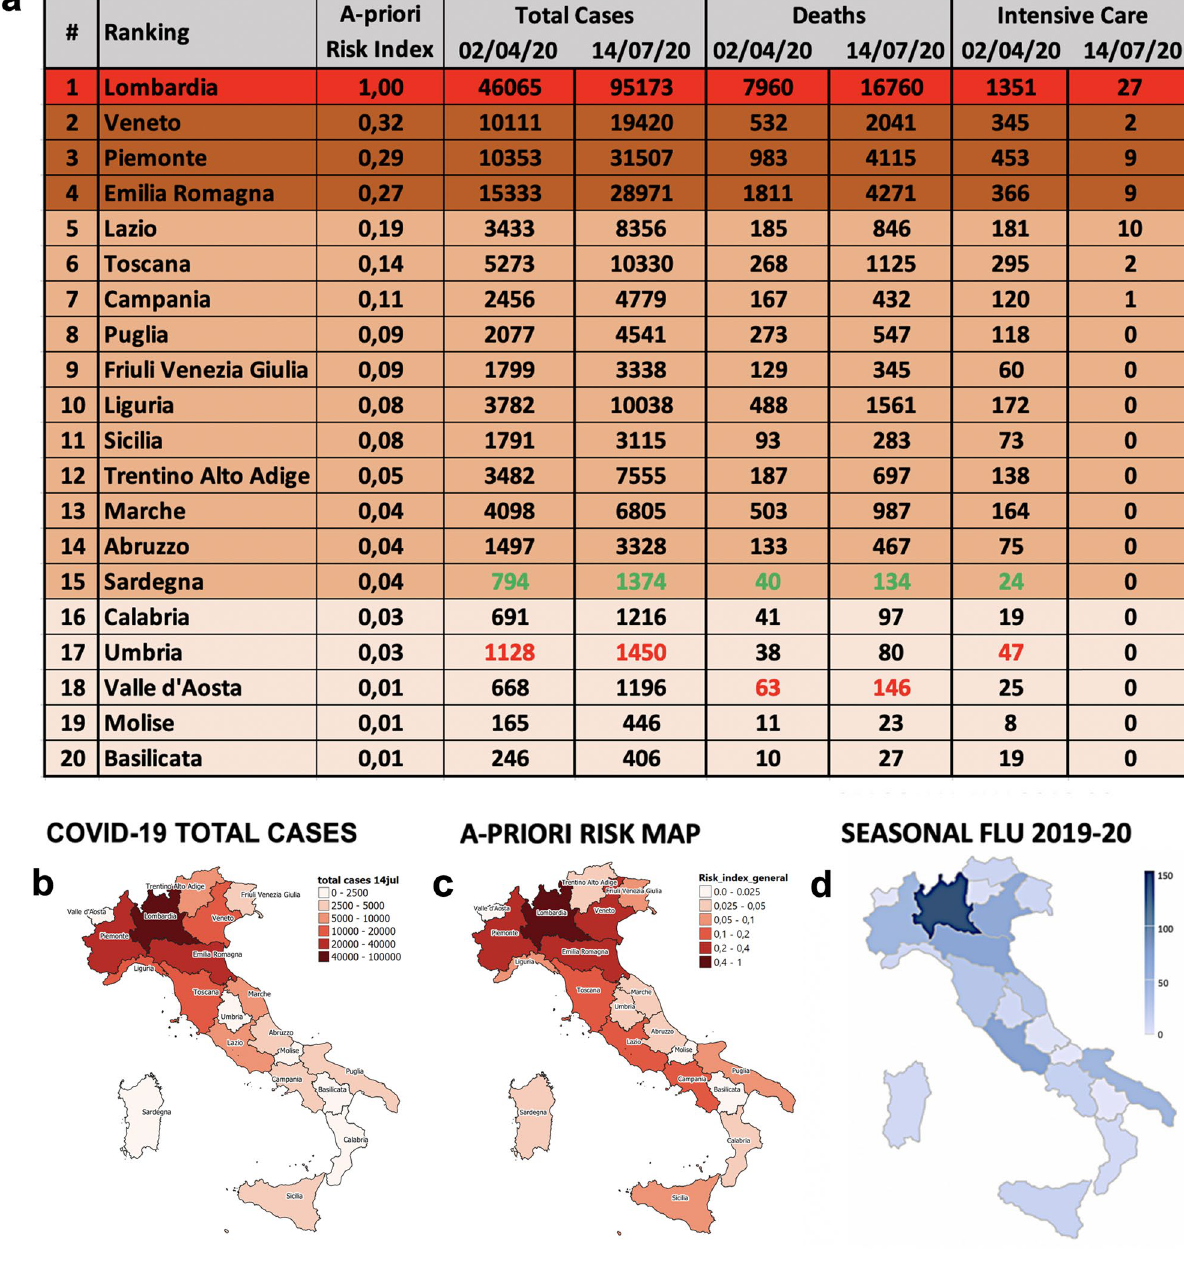
Figure 3. ( a ) A-priori normalized risk ranking of Italian regions, emerging from our analysis of risk indicators, compared with the corresponding total cases, deaths and intensive care occupancy updated, respectively, at April 2, 2020 (just before the epidemic peak) and at July 14, 2020 (at the end of the first wave). Regions are organized in four risk groups, corresponding to different colors: very high, high, medium and low risk. The agreement with the observed effects Data referring to overestimations or underestimations of risk are also colored in green and red, respectively. ( b – d ) Comparison between the spatial distribution of COVID-19 total cases at July 14, 2020 ( b ), the most struck regions (in terms of severe cases and deaths) from 2019–2020 seasonal flu ( d ) according to the ISS data 19 and our a-priori risk map ( c ). The geographical correlation with the risk map is evident for both kind of epidemic flus. Maps were realized with QGIS 3.10 (https:// qgis. org/ en/